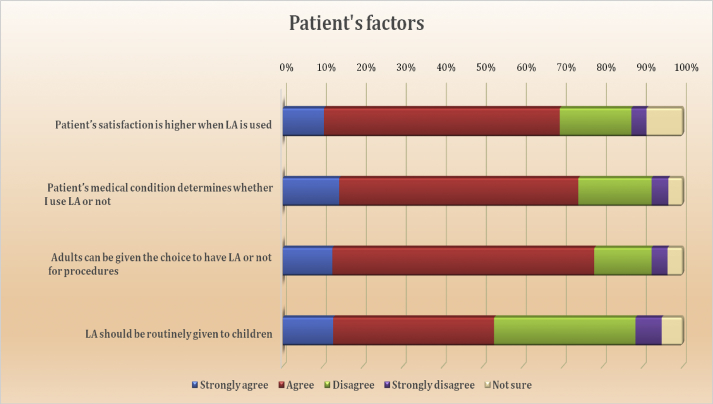
Patient's factors.